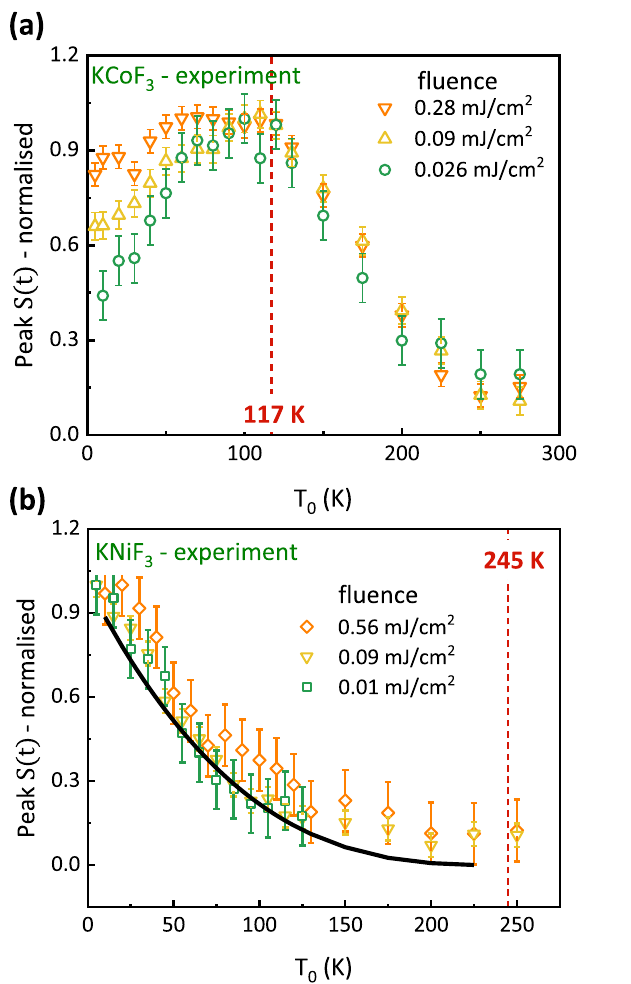
Fig. 3 | Temperature dependence of terahertz emission. a Temperature dependence of the peak THz emission in KCoF 3 for varying pump fl uences. b Temperature dependence of the peak THz emission in KNiF 3 for varying pump fl uences.Theblacklinerepresentsthefunction 1 (cid:2) T noise level in our time-domain THz emission data. c Calculated integrated